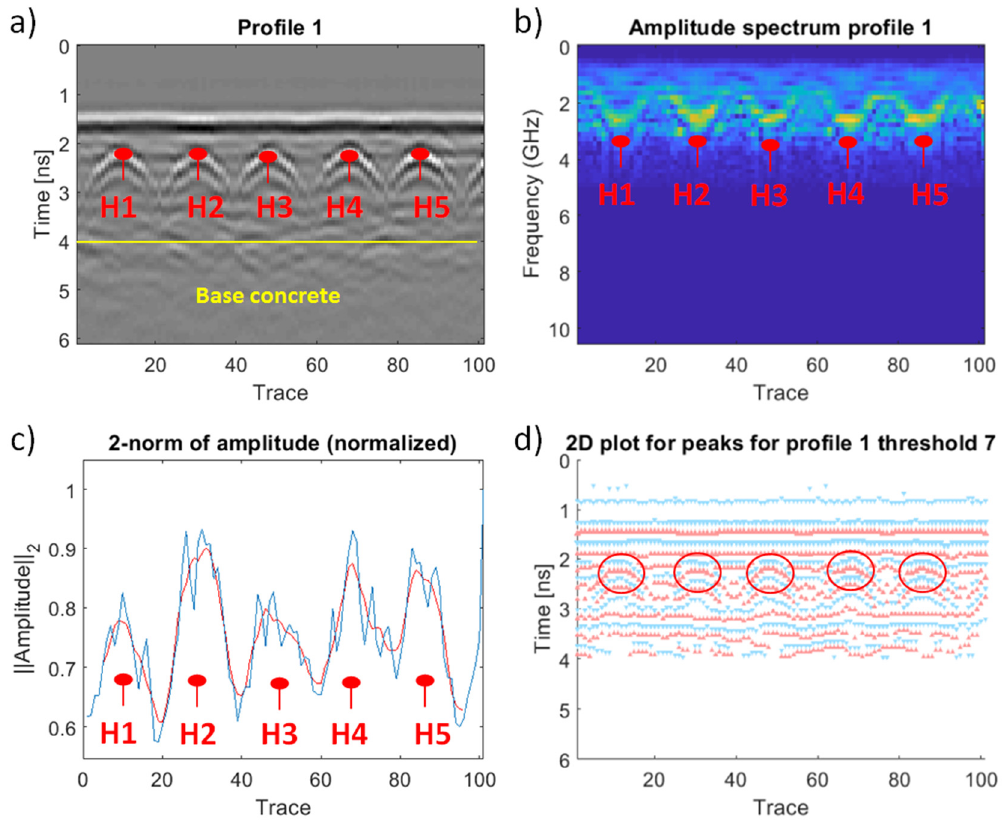
Figure 5. Graphics obtained for GPR profile 1 and interpretation. The five hyperbolic reflections (rebars) produced in this profile line are indicated in graphs ( a ), ( b ), and ( c ) as H1 to H5. The red circles in ( d ) represent a positive polarity of the reflections produced by the rebars.